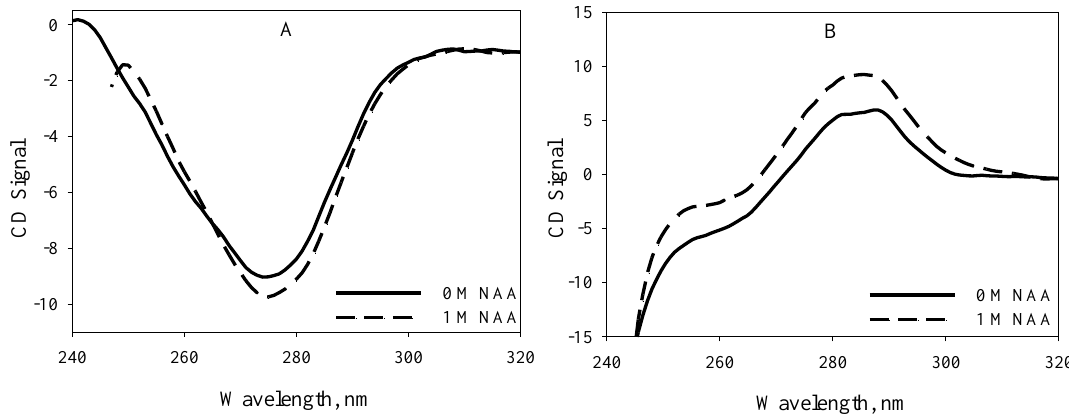
Figure 3. Effect of NAA on the tertiary structure of native proteins at 25 °C. Near-UV CD spectra of the native states of RNase-A ( A ) and lysozyme ( B ) in the absence and presence of NAA at pH 7.0.